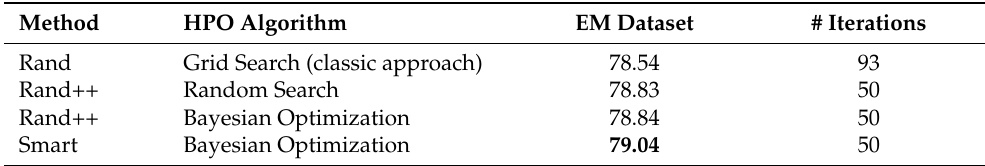
Table 6. Comparison of RandAugment variants with SmartAugment on the EM dataset. For each of the results, we took the test mean IoU of the best three performing configurations evaluated on the validation set. The results show that SmartAugment outperforms RandAugment(++), independent of the hyperparameter optimization